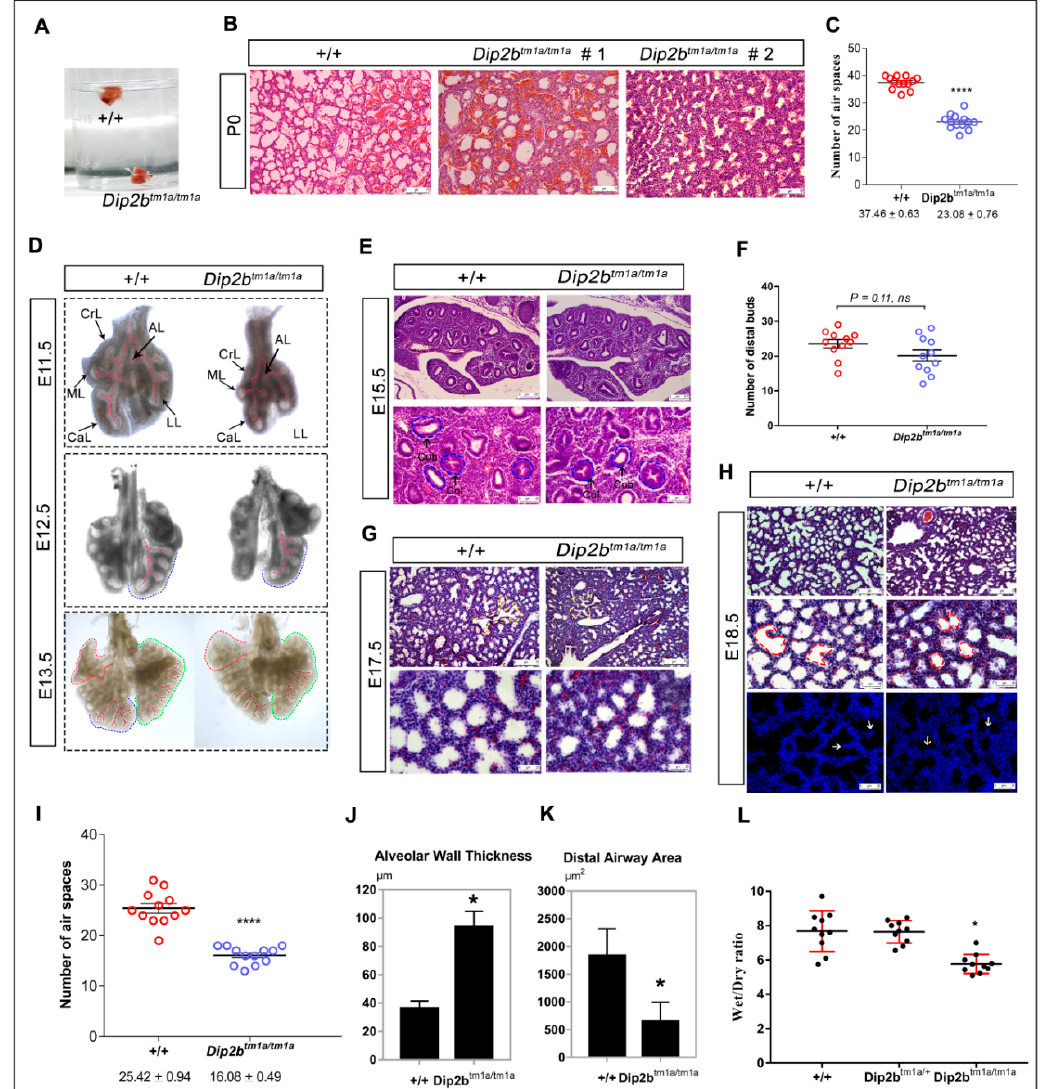
Figure 4. Lung structure comparison of WT and Dip2b tm1a / tm1a littermates: ( A ) Phenotype of a postnatal day 0 (P0) lungs after birth. The P0 lung was examined while it was floating in PBS; ( B ) The morphology of lung tissue and alveoli air space in WT and Dip2b tm1a / tm1a at P0. H&E-stained (Scale bar, 75 µ m) lungs is shown; ( C ) Number of alveolar air space in WT and and Dip2b tm1a / tm1a mice; ( D ) Whole-mount of E11.5–E13.5 lungs of Dip2b tm1a / tm1a (left) and wild-type (right) mice. CrL, right cranial lobe; ML, right medial lobe; CaL, right caudal lobe; AL, right accessory lobe; LL, left lobe; ( E ) The morphology of lung tissue in WT and Dip2b tm1a / tm1a at E15.5. H&E-stained (Scale bar, 100 µ m and 25 µ m) lungs is shown. Col, columnar epithelium; Cub, cuboidal epithelium; ( F ) Quantification of distal epithelial buds in E15.5 lungs; ( G , H ) The morphology of lung tissue in WT and Dip2b tm1a / tm1a at E17.5 and E18.5 is shown. Alveolar septation is shown by white arrow. H&E and DAPI stained (Scale bar, 75 µ m and 25 µ m) lungs are shown; ( I – K ) Number of alveolar spaces, size and thickness in WT and Dip2b tm1a / tm1a mice at E18.5; ( L ) Wet / dry ratio of E18.5 lung tissues. Data are means ± SD ( n = 3, * p < 0.5, **** p < 0.0001 and NS: p = 0.11) calculated by standard two-tailed unpaired t -test.